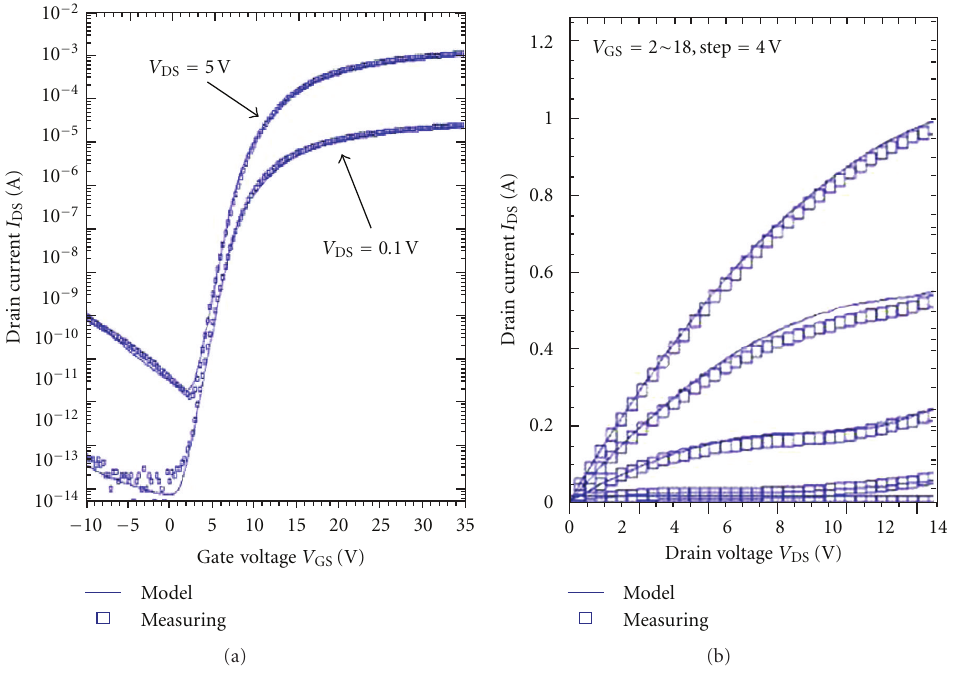
Figure 3: The I - V characteristics of LPTS TFT: (a) transfer curve (b) output curve.